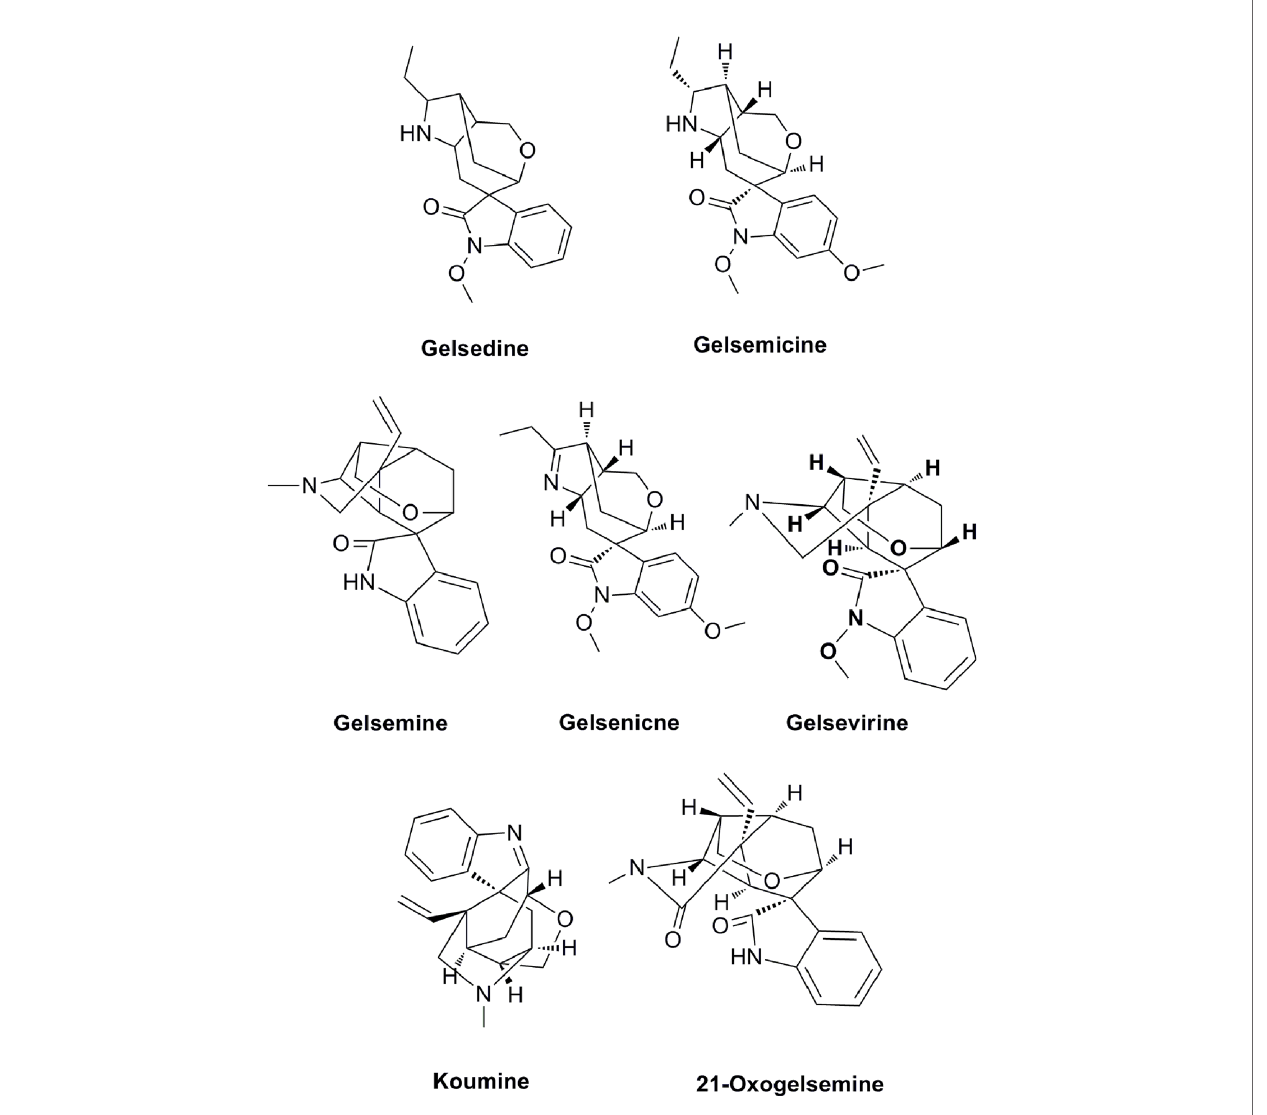
FIGURE 1 | Seven effective components of G.